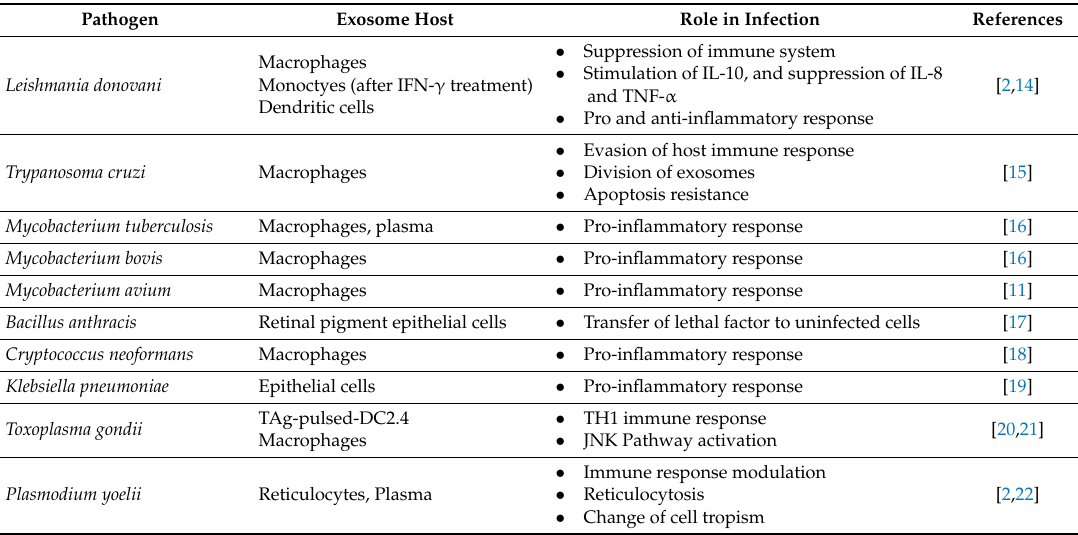
Table 1. Exosomes and their role in pathogenic